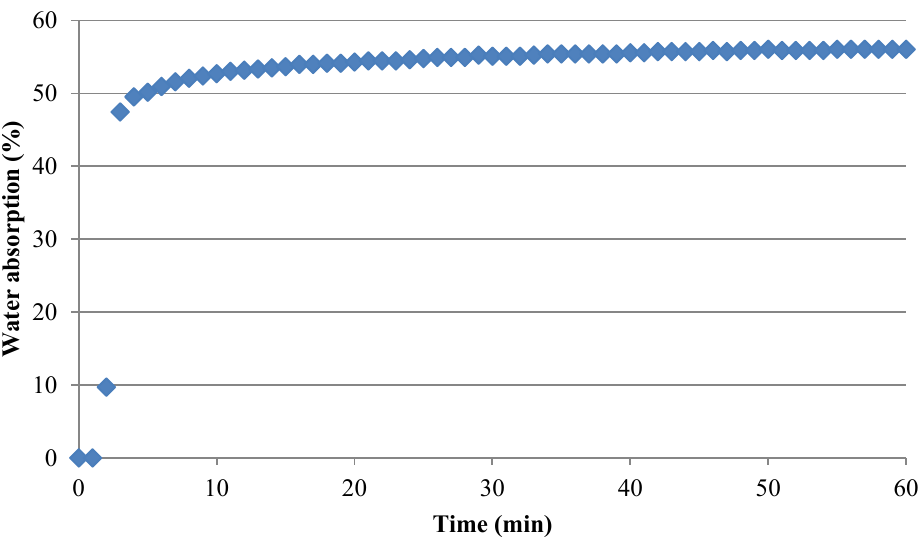
Figure 4. Percentage of water absorption during the first hour of